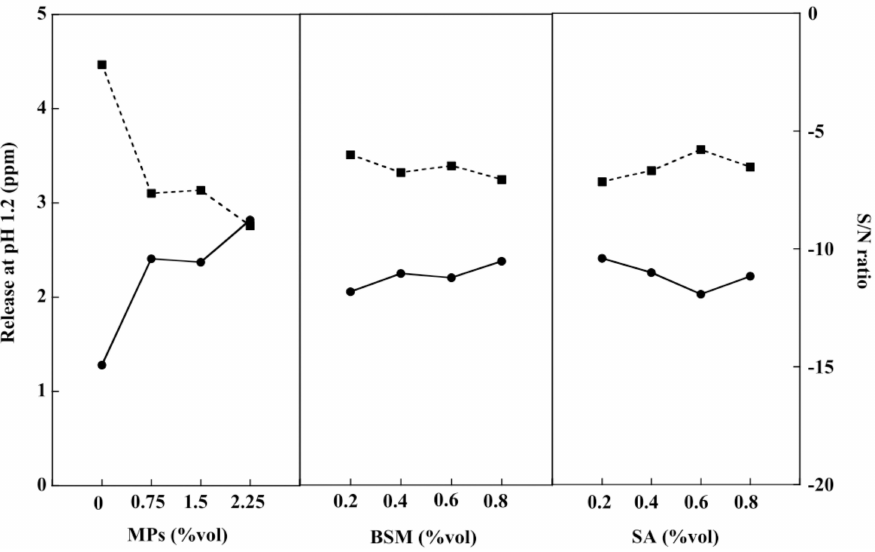
Figure 6. Drug release at pH 1.2 (– • –) and S/N ratio (– (cid:4) –) of the BSM/SA/MPs hydrogel beads. The swelling ratio of the hydrogel beads at pH 1.2 after 3 h of incubation was less than 0.6% due to the pKa of SA being about 3.2 [46], and the formation of insoluble alginic acid resulted in protonation of carboxyl groups (–COOH) in SA. However, ionization of the carboxyl groups of SA (–COO–) took place at pH 7.4. Due to osmotic pressure and increased intermolecular electrostatic repulsion forces, water penetration occurred on the internal structure of the hydrogel